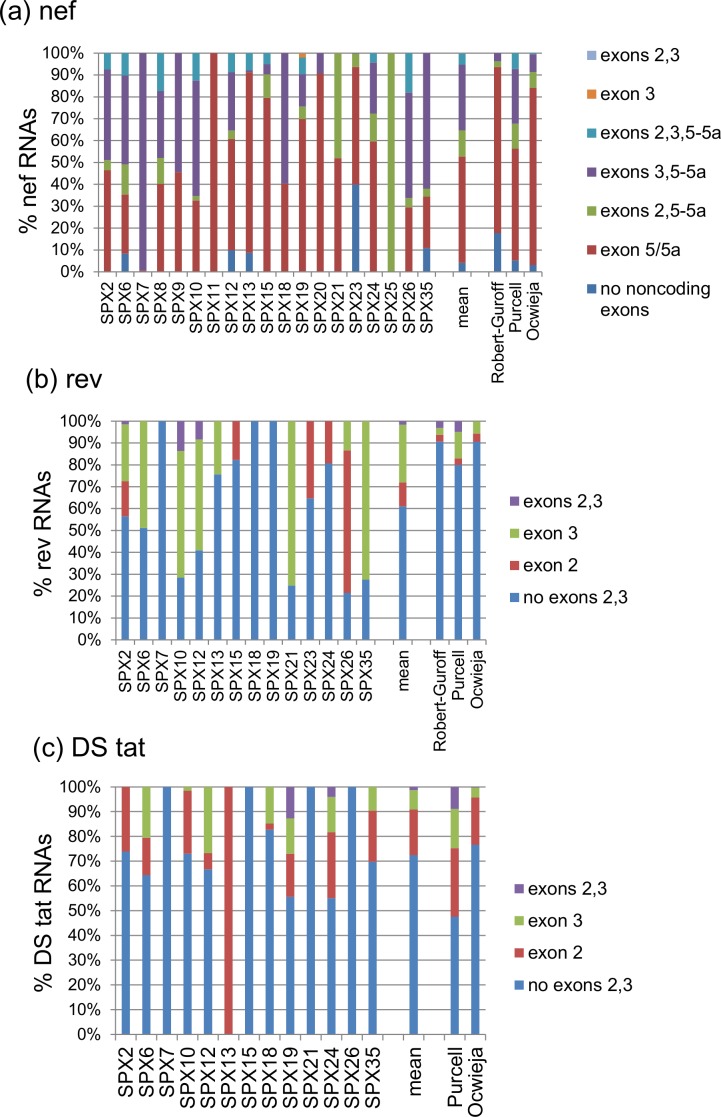
Frequency of incorporation of noncoding exons in DS RNAs among (a) nef, (b) rev, and (c) tat RNAs. The vertical axis represents proportions relative to all transcripts of each class. Mean proportions of all samples are shown on the right of the columns for individual samples. For comparison, proportions reported in in vitro studies by Robert-Guroff et al. [2], Purcell and Martin [6], and Ocwieja et al. [9] are shown.